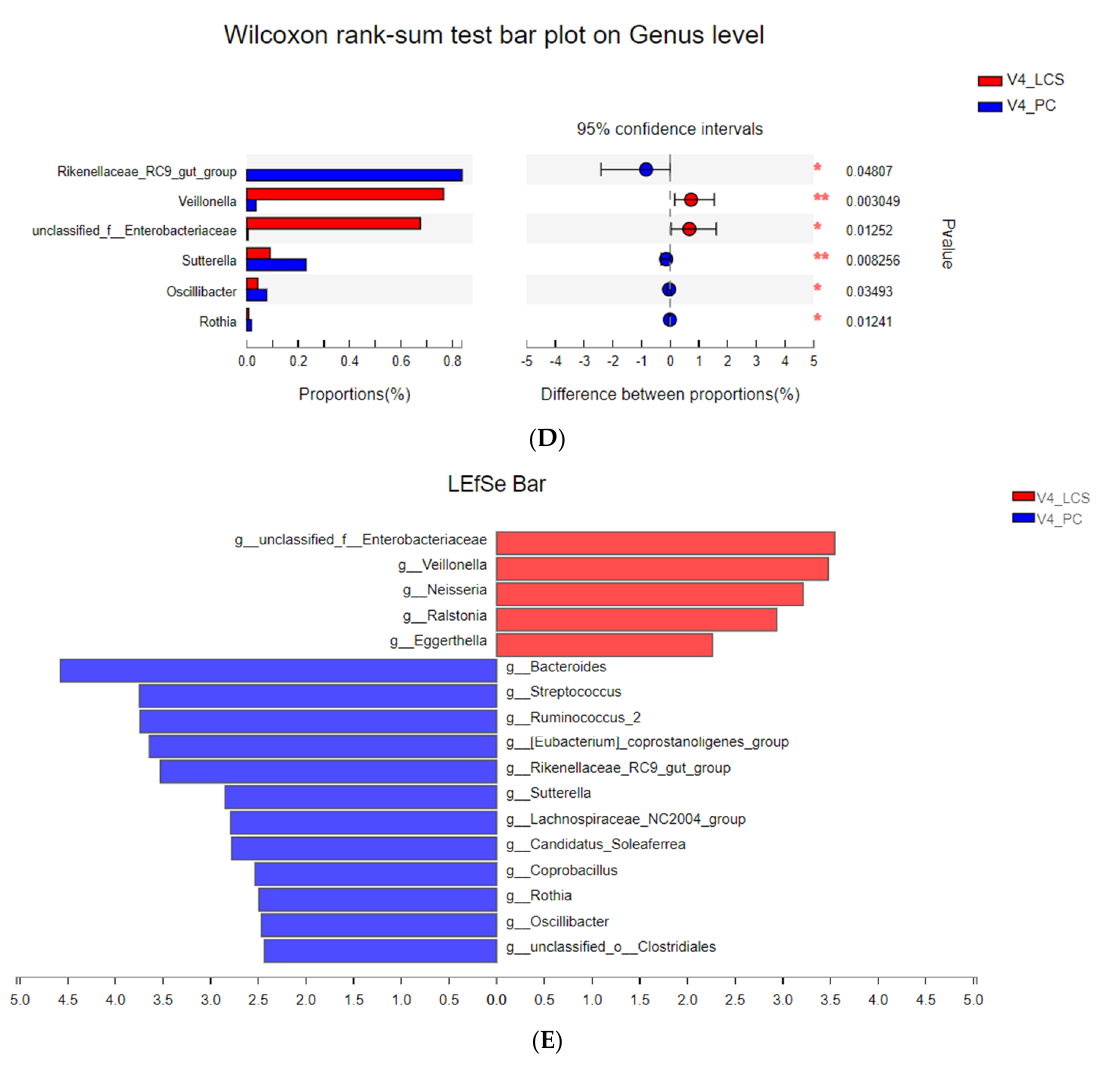
Figure 5. The effects of LcS on the gut microbiota on the genus level. ( A ) The relative abundance of the main genera was >1% in the different groups. ( B ) Significantly different genera levels between V1 and V4 of the LcS group analyzed by the Wilcoxon rank-sum test. ( C ) Significantly different genera levels between V1 and V4 of the placebo group analyzed by the Wilcoxon rank-sum test. ( D ) Significantly different genera levels between V4 of the LcS and placebo groups analyzed by the Wilcoxon rank-sum test. ( E ) Linear discriminant analysis (LDA) integrated with the effect size (LEfSe) analysis indicating genera that were significantly differentially abundant between V4 of the LcS and placebo groups (LDA score ≥ 2). * p < 0.05 and ** p < 0.01. V1_LCS: samples at V1 in the LcS group, V4_LCS: samples at V4 in the LcS group, V1_PC: samples at V1 in the placebo group, and V4_PC: samples at V4 in the placebo group.